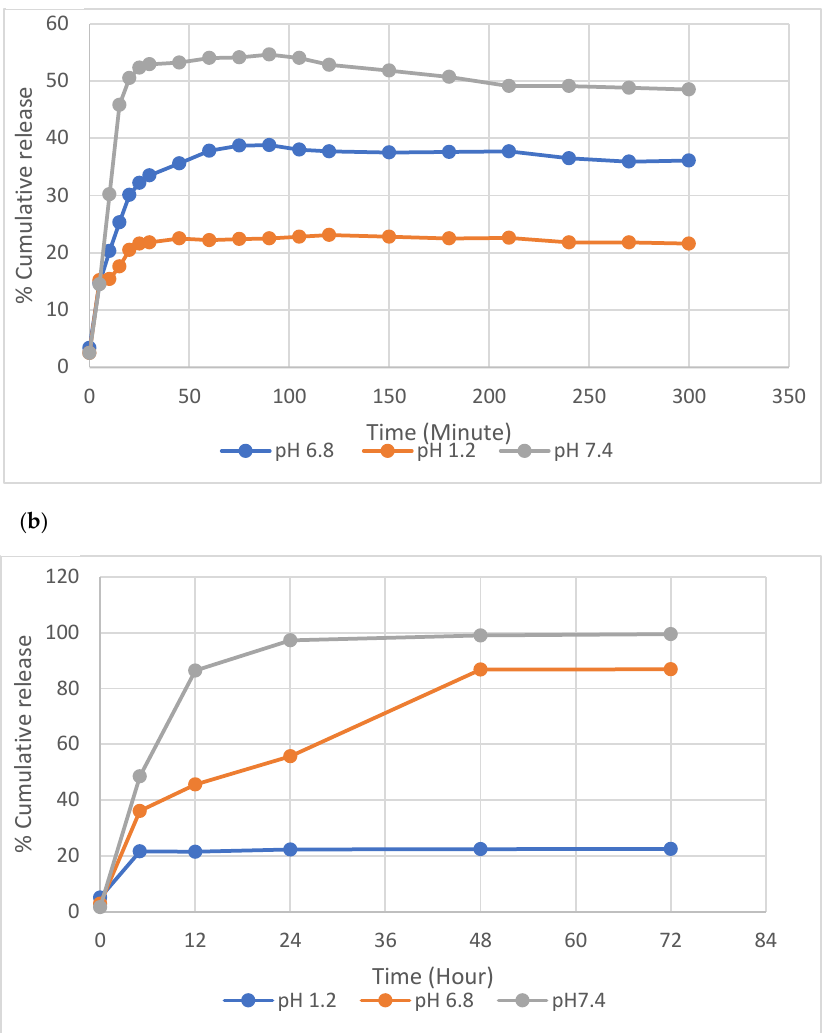
Figure 8. Cumulative release of AML at the different time points (minute ( a ) and hour ( b )) in vitro from AML – p(HEMPA) nanopolymers (loaded AML amount: 1 mg/mL nanopolymer; T: 37 °C).